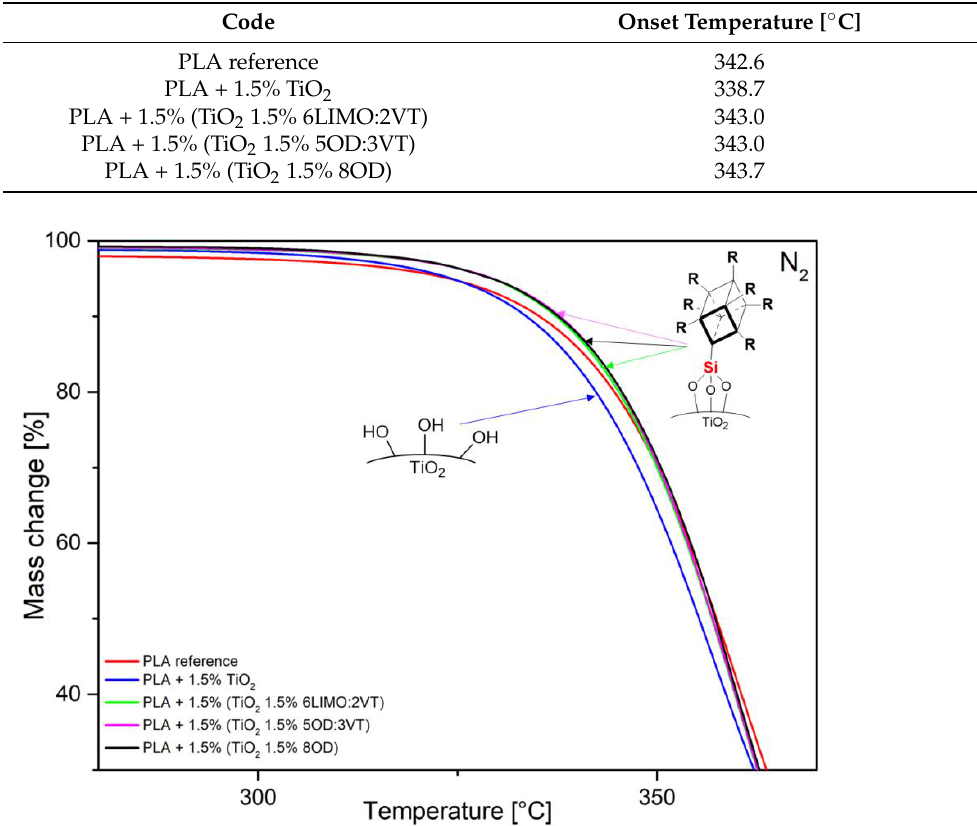
Table 3. Results of thermogravimetric analysis under N 2 atmosphere.